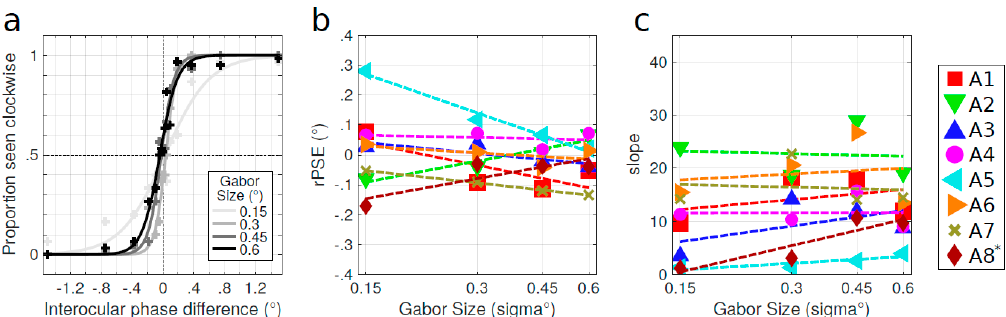
Figure 6. E ff ect of spatial frequency. ( a ) Psychometric functions of the perceived direction of rotation for one amblyopic subject (A3) as a function of the interocular phase di ff erence for di ff erent sizes of the Gabor patches composing the stimulus: 0.15 ◦ , 0.3 ◦ , 0.45 ◦ , and 0.6 ◦ (from light gray to dark gray). Data points are fitted by a logistic function. ( b ) rPSE as a function of the size of the Gabor patches for the eight amblyopic subjects. * rPSE values for subject A8 were divided by 10. ( c ) Slopes of the psychometric functions. Dashed lines represent linear regression. Quality of fit and regression parameters are reported in Table S1 (Supplementary Materials, Sheet 2).